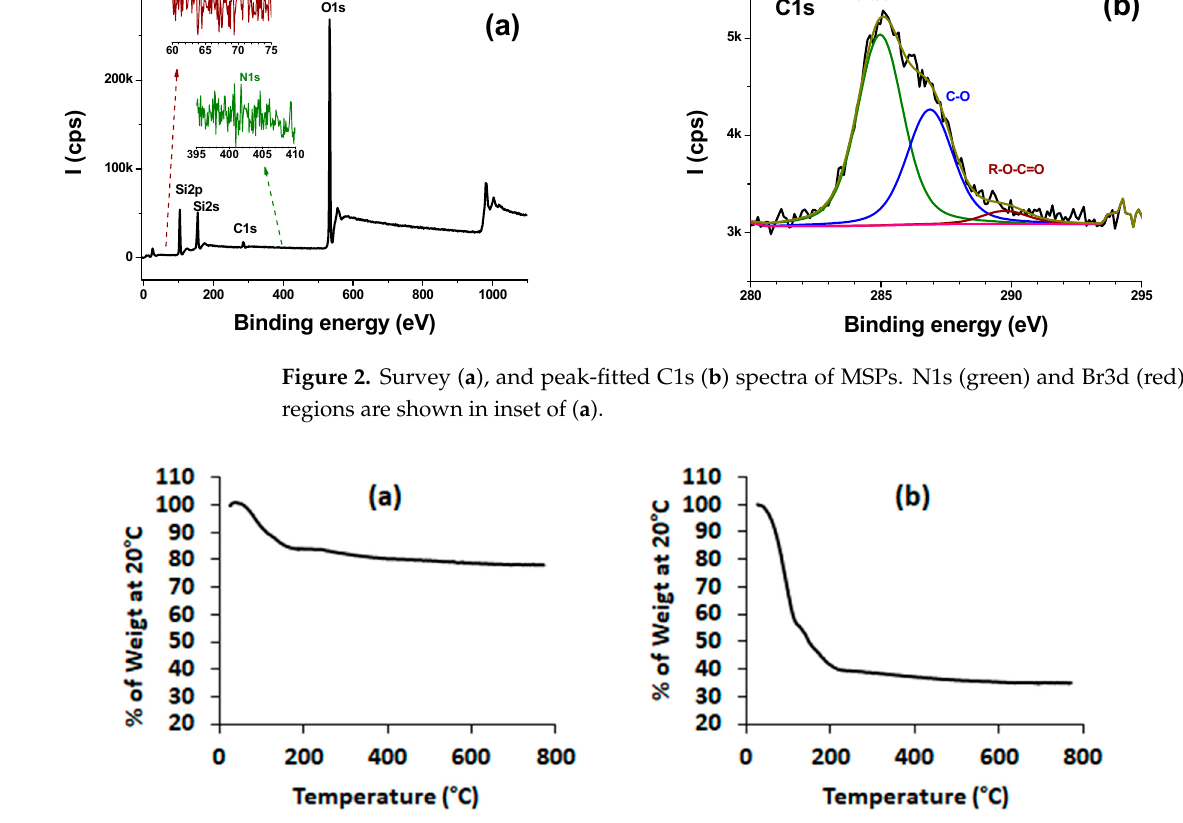
Figure 2. Survey ( a ), and peak- fi tt ed C1s ( b ) spectra of MSPs. N1s (green) and Br3d (red) narrow regions are shown in inset of ( a ).